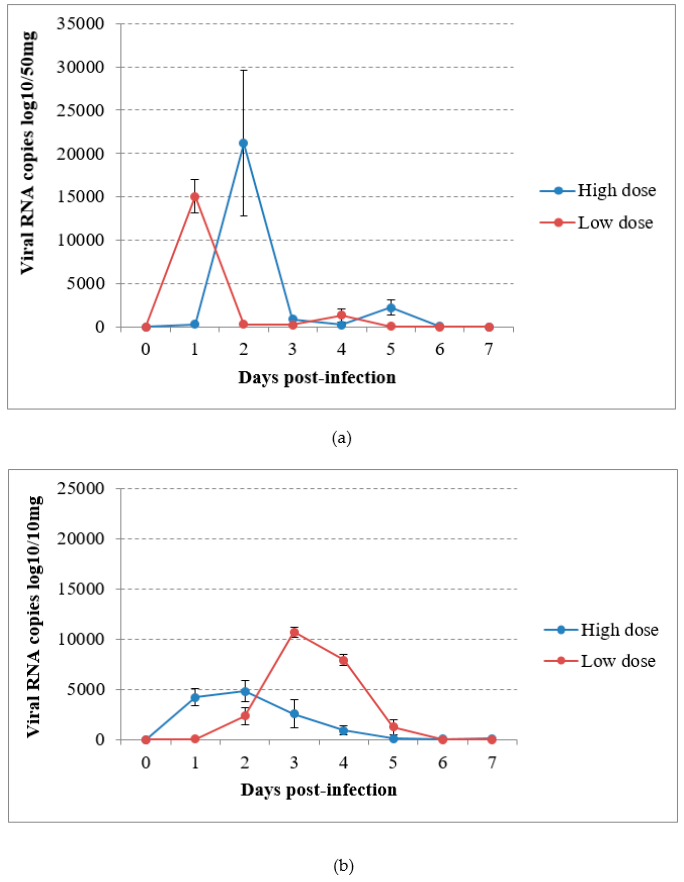
Figure 4. Viral RNA loads detected by RT-qPCR in ( a ) droppings and ( b ) immature feathers from canaries infected intraperitoneally with the Usutu virus.